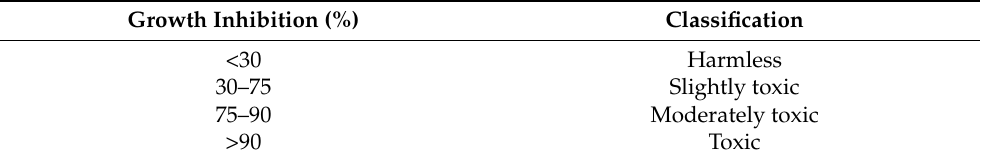
Table 3. Toxicity classification scale [38] (Reproduced with permission from Viñuela et al., Phytoma; published by PHYTOMA-España,